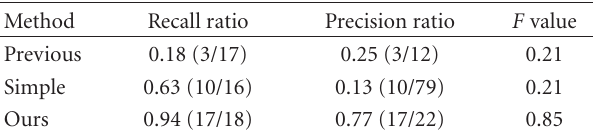
Table 2: The classification ratios.